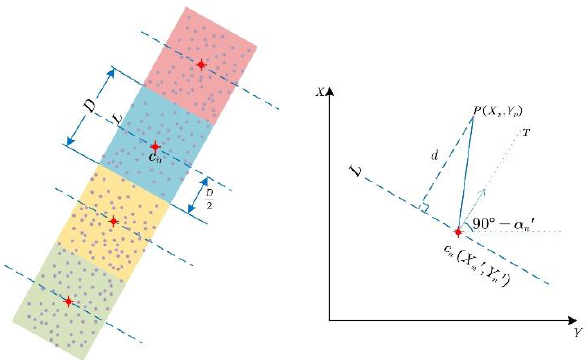
Figure 3. The diagrammatic sketch of slicing point